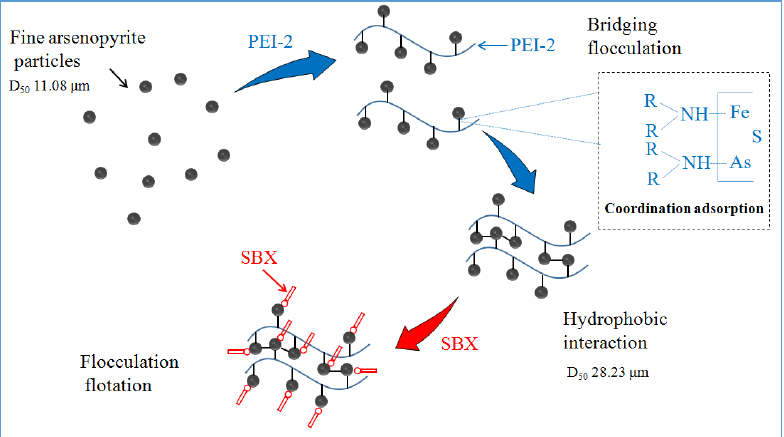
Figure 9. The possible flocculation mechanism of PEI-2 improved the flotation system of arsenopyrite.